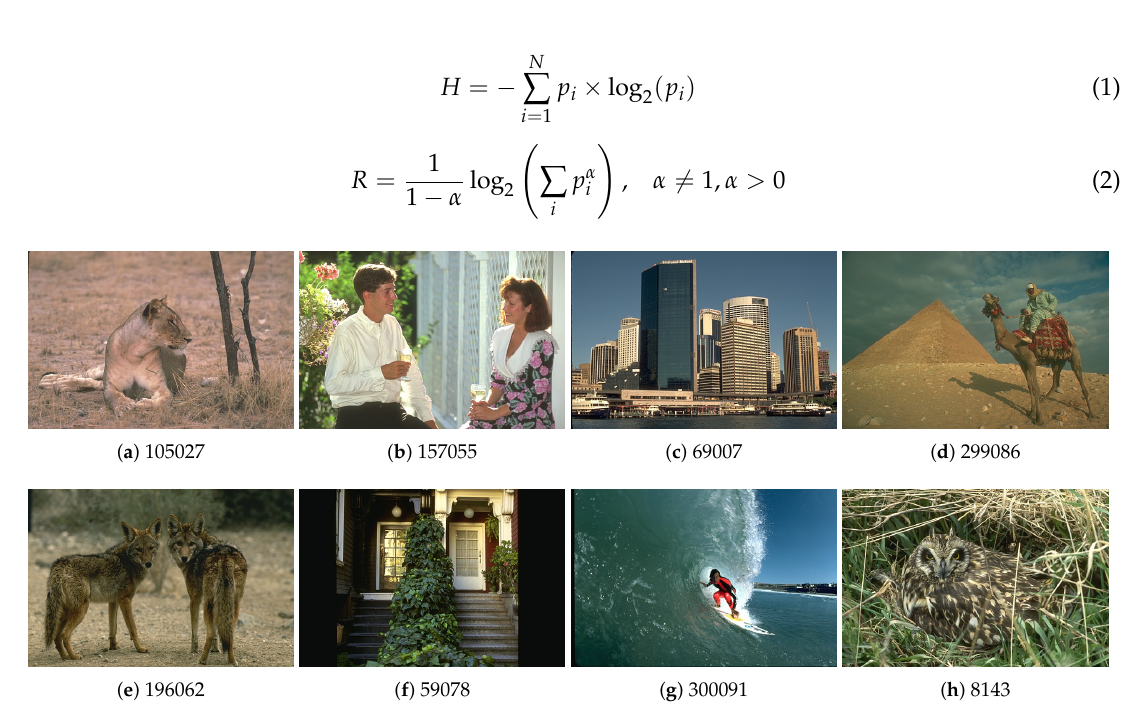
Figure 2. Examples of images from the BSDS500 data